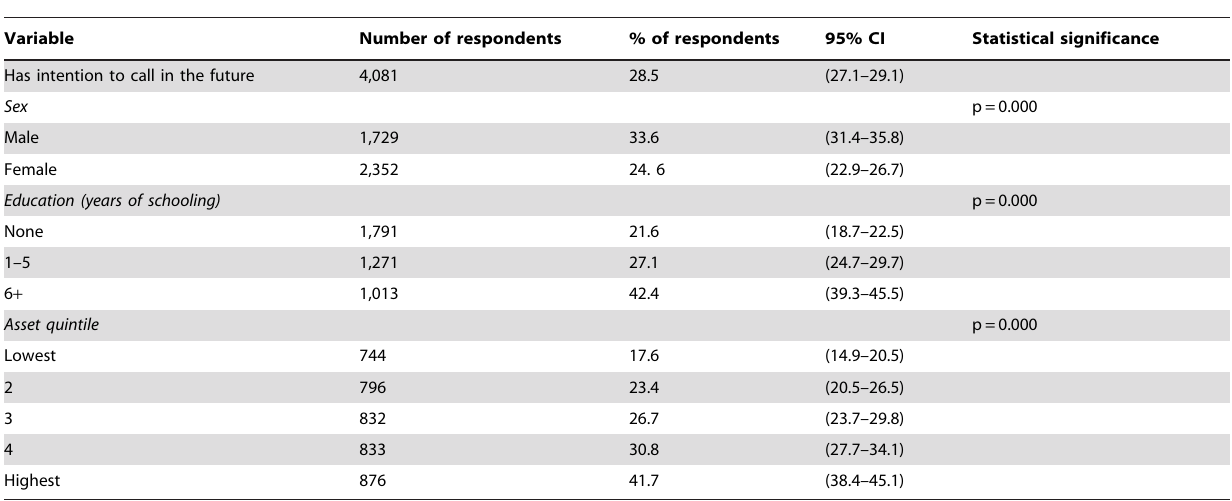
Table 8. Intention to use mHealth in the